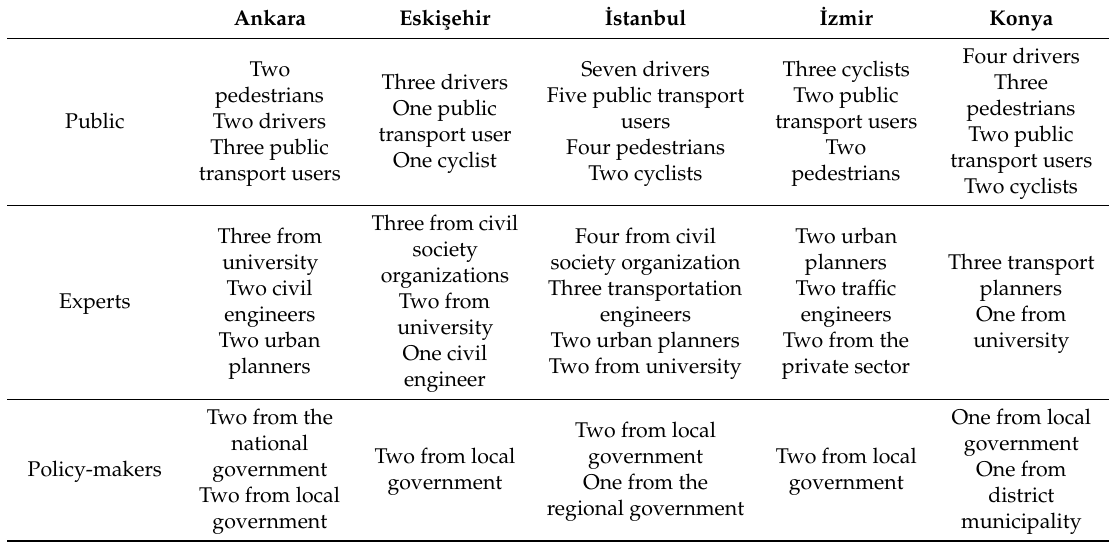
Table 2. Description of participants in the semi-structured